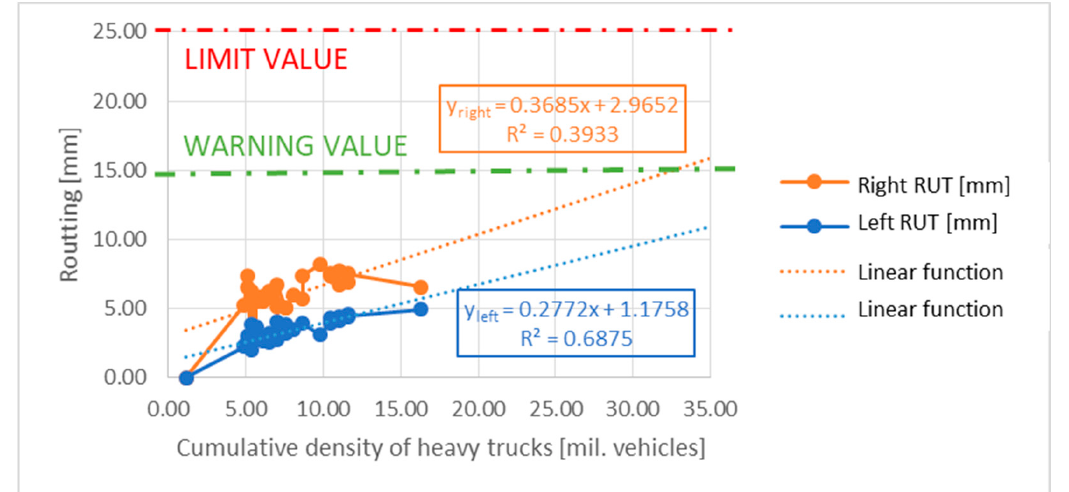
Figure 6. Rutting for left and right rut and probable course.